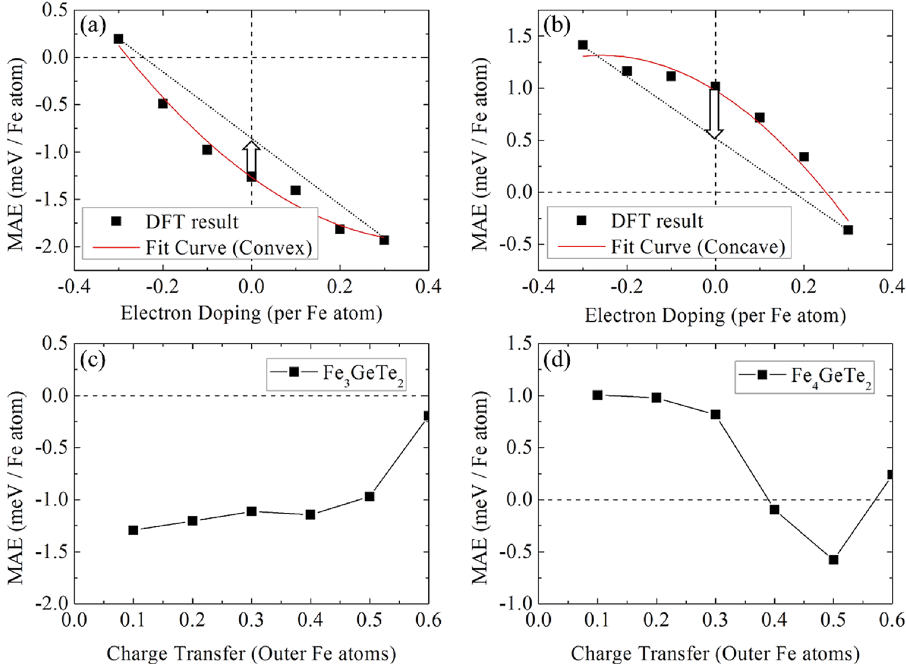
Figure 4. The calculated MAE under charge doping in ( a ) Fe 3 GeTe 2 and ( b ) Fe 4 GeTe 2 . The red lines denote parabolic fitted curves for DFT results, which shows the convex and concave behaviors of the MAE under charge dopings for Fe 3 GeTe 2 and Fe 4 GeTe 2 , respectively. The change of the MAE for the asymmetric doping of ( c ) Fe 3 GeTe 2 and ( d ) Fe 4 GeTe 2 . Fe OUT(1) and Fe OUT(2) atoms are oppositely doped keeping the overall charge